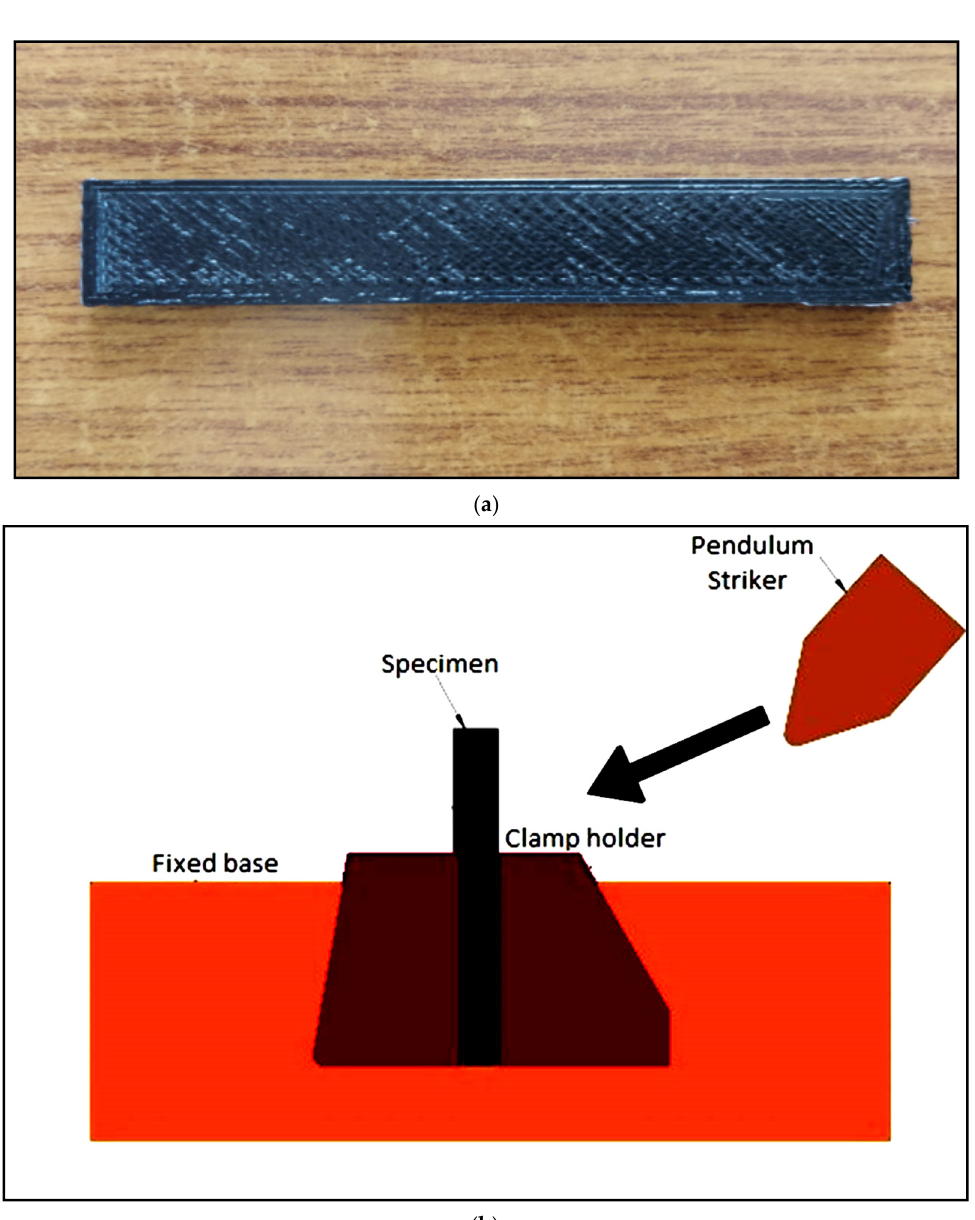
Figure 7. ( a ) Photograph of impact test specimen developed by FDM. ( b ) Photograph of scheme of loading during Izod impact test.